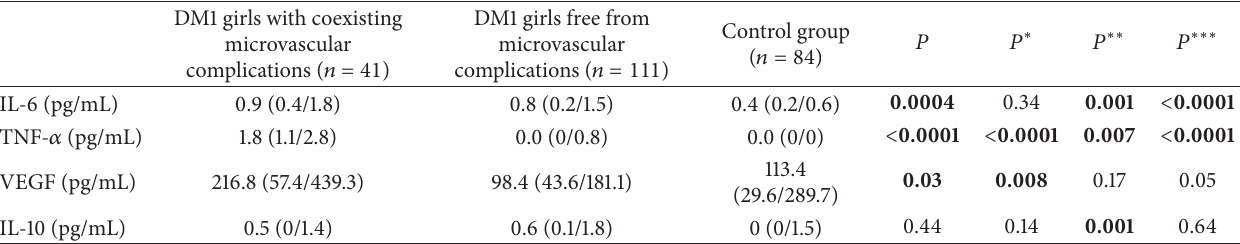
Table 5: The level of serum cytokines in analyzed subjects.